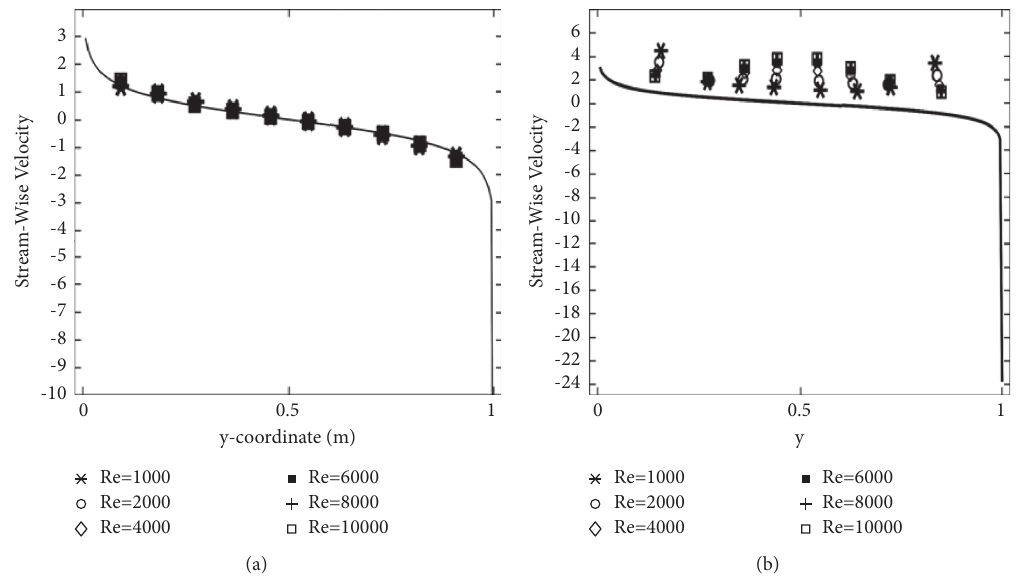
Figure 3: (a) Comparison of the asymptotic solution with the numerical solution in presence of screen only. (b) Comparison of the asymptotic solution with the numerical solution in the presence of screen and circular cylinder.